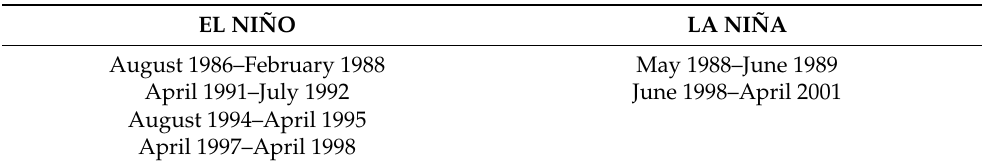
Table 1. El Niño and La Niña events between 1985 and 2001 determined by assessing Oceanic Niño Index and Southern Oscillation Index historical